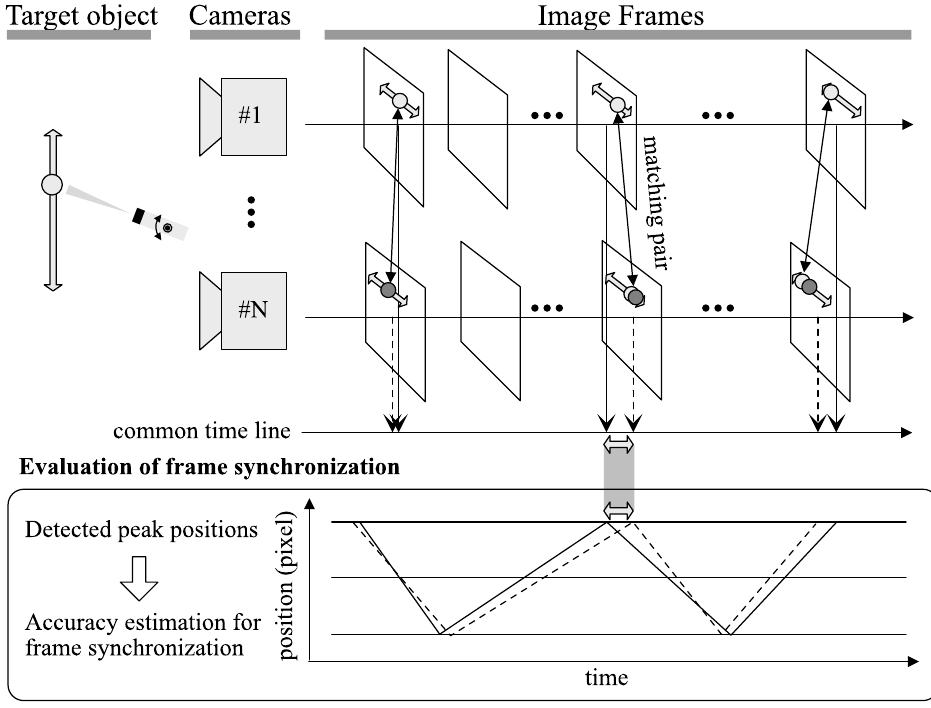
Figure 1. Suggested concept to evaluate the frame synchronization. Temporal skew of corresponding images captured by multiple cameras is shown as the position shift of the target object in each image frame. By detecting the position shift, the temporal skew that indicates frame synchronization can be estimated. This paper deals with how accurately the frame synchronization can be estimated by producing legible shift patterns and detecting the extent of the